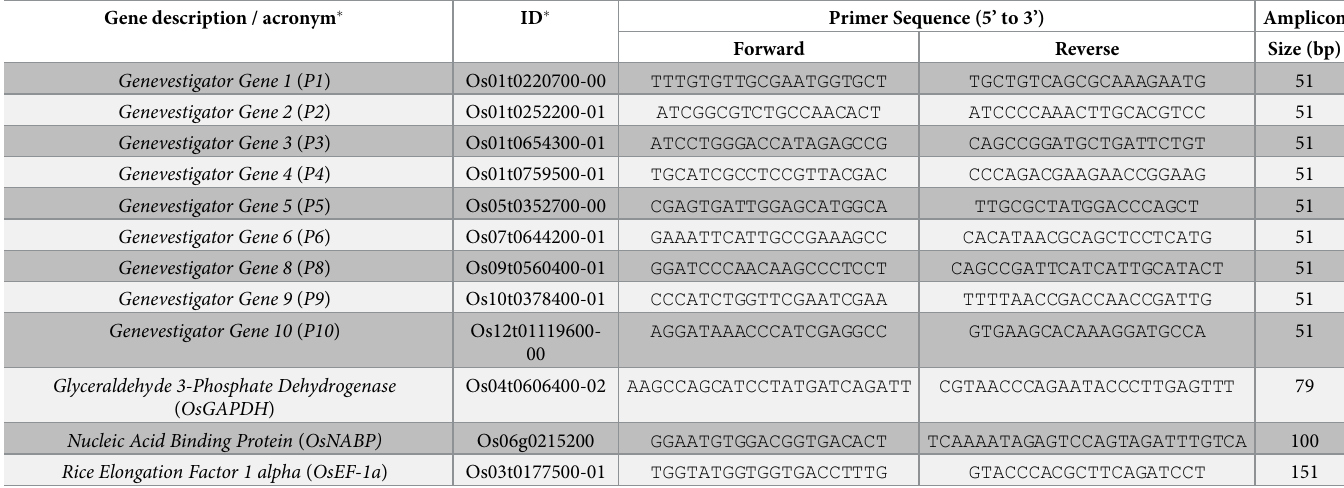
Table 1. Genome and amplification information on the candidate reference genes 1–10 (cid:3)(cid:3) . Gene description / acronym (cid:3) ID (cid:3) Primer Sequence (5’ to 3’)